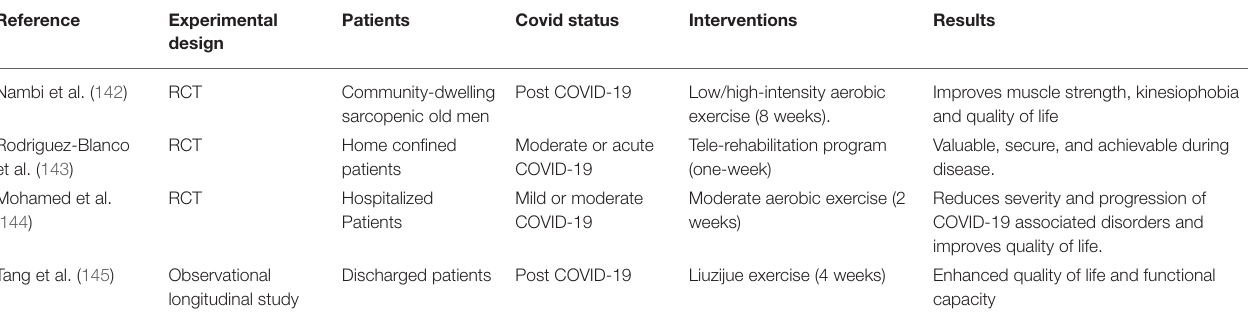
TABLE 1 | Potential treatments of sarcopenia and weakness in patients with post-acute sequelae of COVID-19. Reference